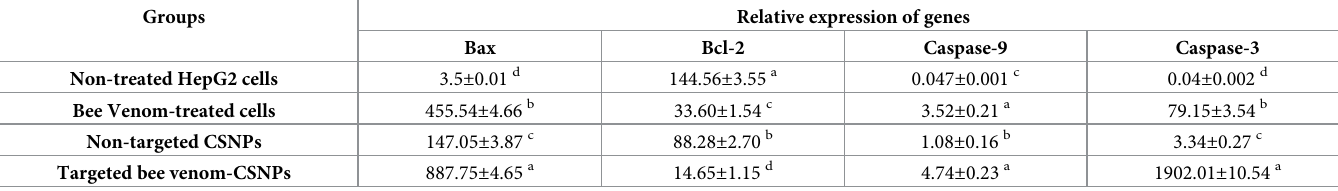
Values are expressed as mean ± SE, (n = 3), means for the same parameter with different letters in each bar are significantly different (p < 0.01), where the highest data value takes the letter